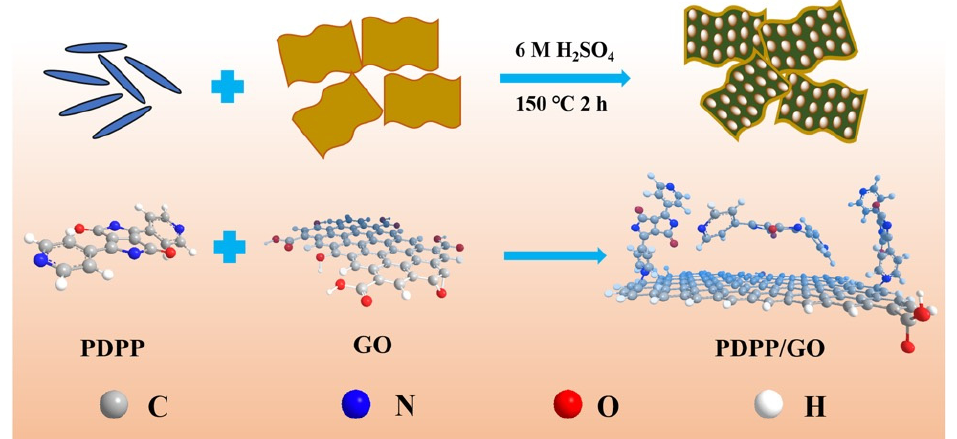
Figure 4. The reaction and structure diagrams of